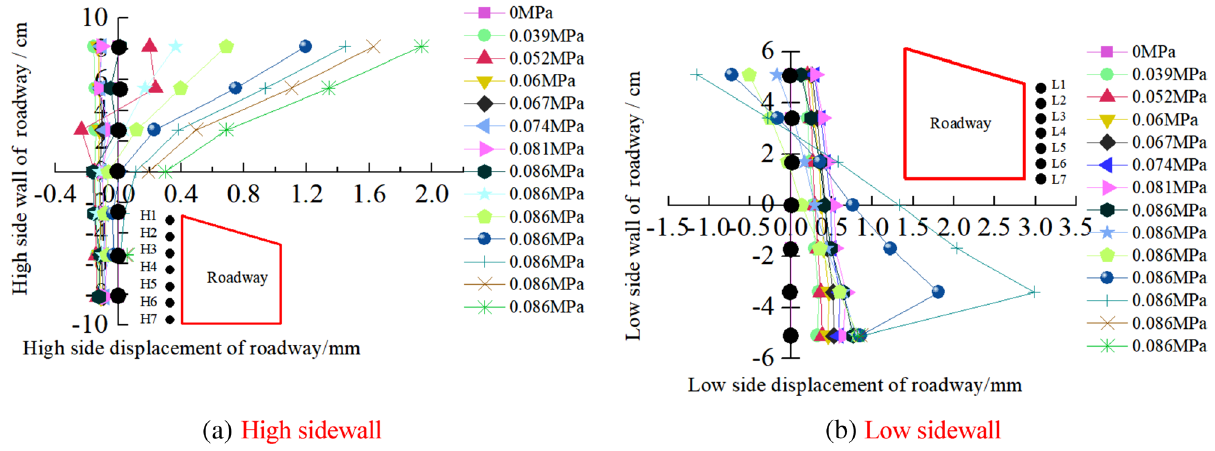
Figure 7. Evolution of surrounding rock on shallow surface of two sidewalls of roadway with